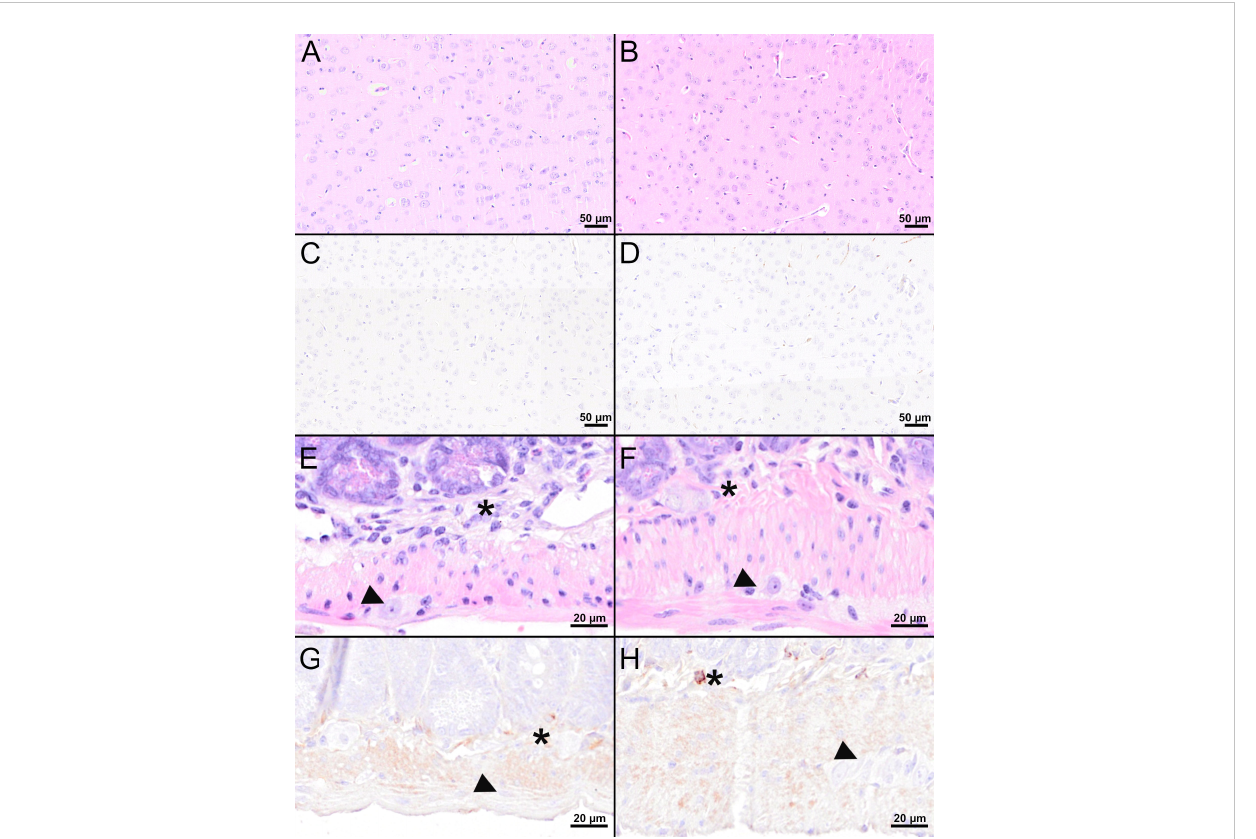
FIGURE 7 Histological and immunohistochemical analyses of the cerebral cortex and jejunum at 16 dpi. (A, B, E, F) H&E-stained sections of the cerebral cortex (A, B) and jejunum (E, F) of TBEV-infected mice which were either vaccinated with FSME-IMMUN ® (A, E) or MVA-prME (B, F) . (C, D, G, H) IHC for TBEV E antigen of the cerebral cortex (C, D) and jejunum (G, H) of TBEV-infected mice either vaccinated with FSME-IMMUN ® (C, G) or MVA-prME (D, H) . (A, B) No signi fi cant microscopic lesions within the cerebral cortex parenchyma are visible. (C, D) TBEV immunoreactivity was absent within the parenchyma of the cerebral cortex. (E, F) The jejunum shows mild hypercellularity of the submucosal plexus (asterisk), while the myenteric plexus (arrowhead) reveals no signi fi cant fi ndings. (G) No speci fi c TBEV immunoreactivity is detectable in the submucosal (asterisk) or the myenteric plexus (arrowhead). (H) A single cell in the submucosal plexus (asterisk) is immunolabeled, while no immunoreactivity is present in the myenteric plexus (arrowhead). Scale bars: (A – D) 50 µM, (E – H) : 20